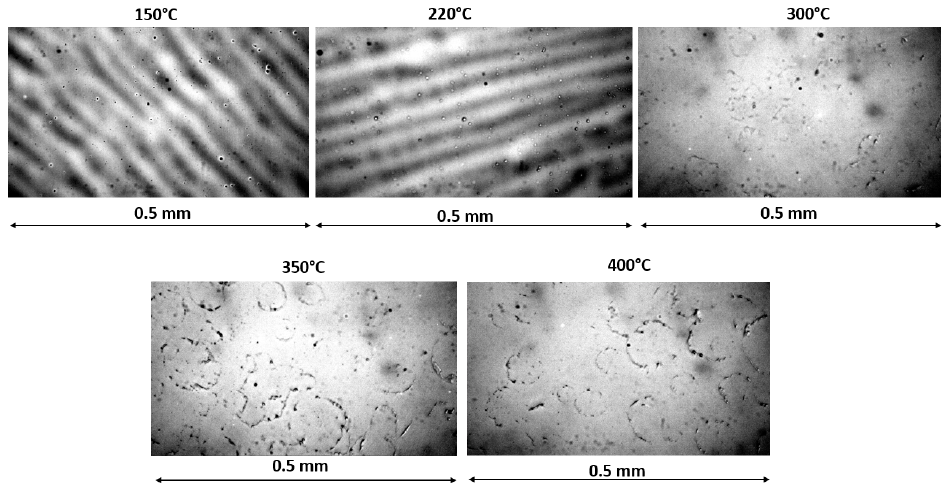
Figure 8. Microscopic pictures of PSAN film surface with wt = 0.5% annealed at different tempera- tures.